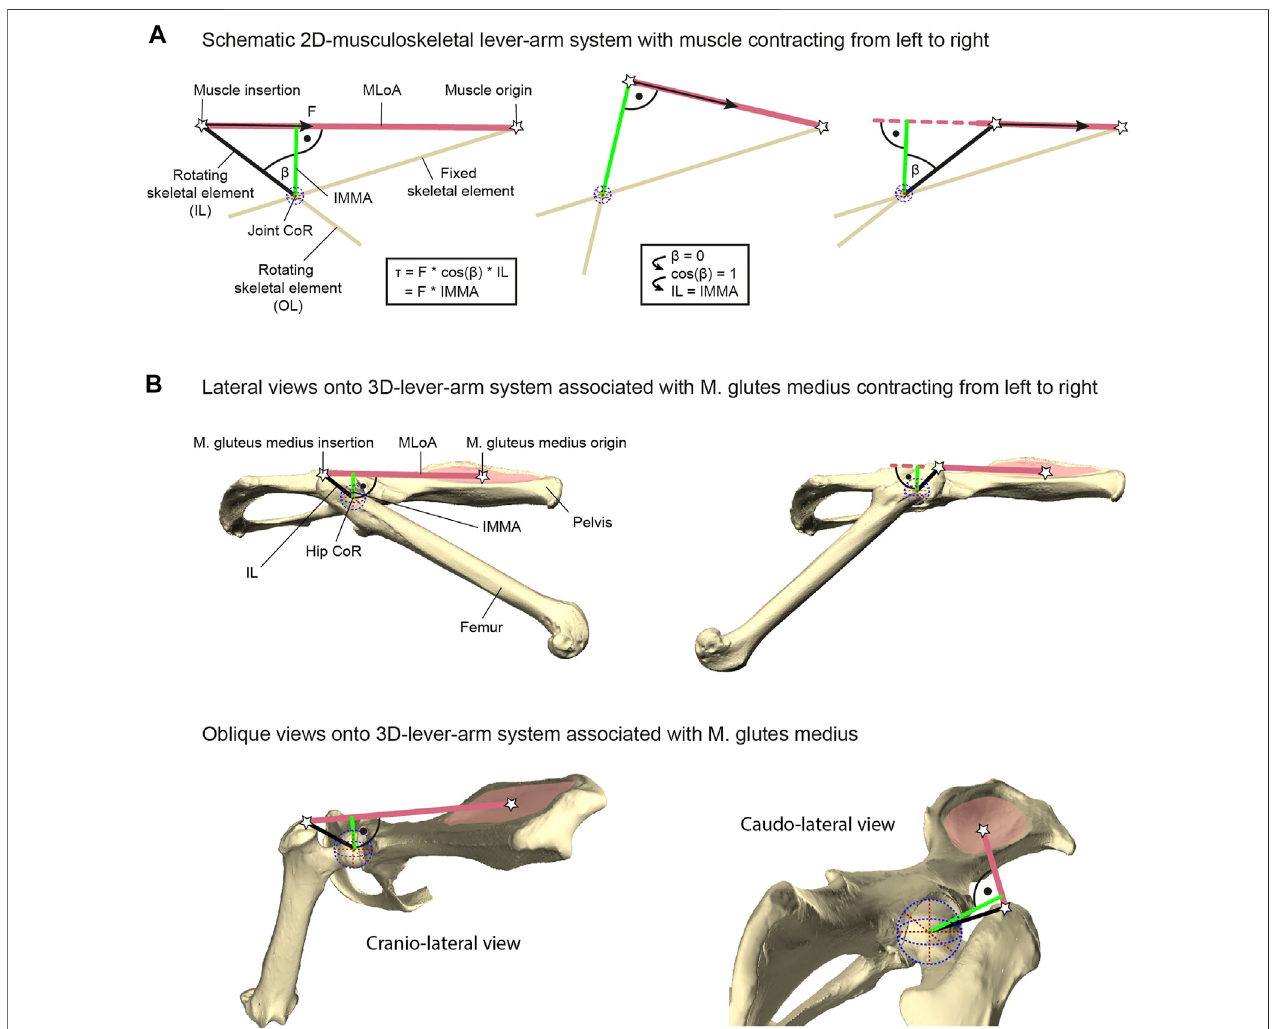
FIGURE 1 | Explanation of lever-arm system components exempli fi ed with the herein studied M. gluteus medius system. (A) Geometric properties of a schematic musculoskeletal lever-arm system as typically illustrated in a 2D plane, including the instantaneous muscle moment arm (IMMA), osteological in-lever (IL), osteological out-lever (OL), center of rotation (CoR), and the muscle ’ s line of action (MLoA). The skeletal element that includes the IL is modeled as being rotated due to muscle contractionwithrespecttoareferenceelement fi xedinspace(lefttoright).Theequationontheleftshowsdifferentwaysofcomputingthejointtorque( τ )generated by the muscle ’ s force (F) and applies to all poses throughout joint motion. (B) 3D-lever-arm system associated with the M. gluteus medius exempli fi ed using the surface models ofthe right femur and right halfofthe pelvis from thescansof C.pilorides (Desmarest ’ s hutia).Upper panels display lateral views onto the 3D model setup witha hipextendedby30 ° (left)and140 ° (right)at0 ° abduction(comparewithleftandrightpanelsof (A) ,respectively).Lowerpanelsdisplayobliqueviewsontothemodelsetup with a hip extension of 120 ° at 0 ° abduction to highlight the actual 3D nature of the lever-arm system associated with the M. gluteus medius. For further explanation, see